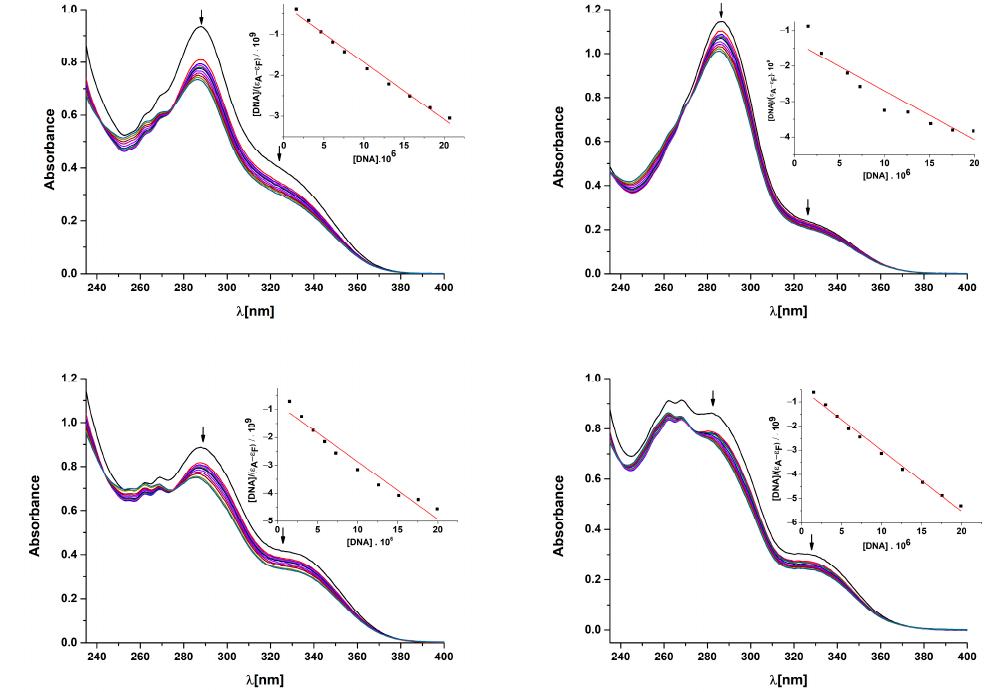
Figure 9. UV-Vis spectra of DMSO/buffer solution of 1 – 4 in the absence and presence of increasing amounts of DNA ( r = [DNA]/[complex] = 0–2.1). Arrows show changes in intensity upon the addition of increasing amounts of DNA. Inset: Plot of [DNA]/( ε A - ε f ) versus [DNA] for complex. The values of the K b binding constants are collected in the Table 6. The obtained values of the K b constants ranged from 1.04 × 10 5 ( 2 ) to 5.46 × 10 5 M − 1 ( 4 ) and are in good Table 6. DNA binding constant and UV spectral features of 1–4 in the presence of agreement with other Cu–fenamate complexes [23,27–30]. Such values indicate relatively strong binding of the studied complexes to DNA, likely due to their ability to form hydrogen bonds with DNA in combination with partial intercalation. Based on their binding strength with DNA, the complexes can be arranged as follows: 4 > 1 > 3 > 2 . The highest values of the binding constant were obtained for complexes with clonixinate and